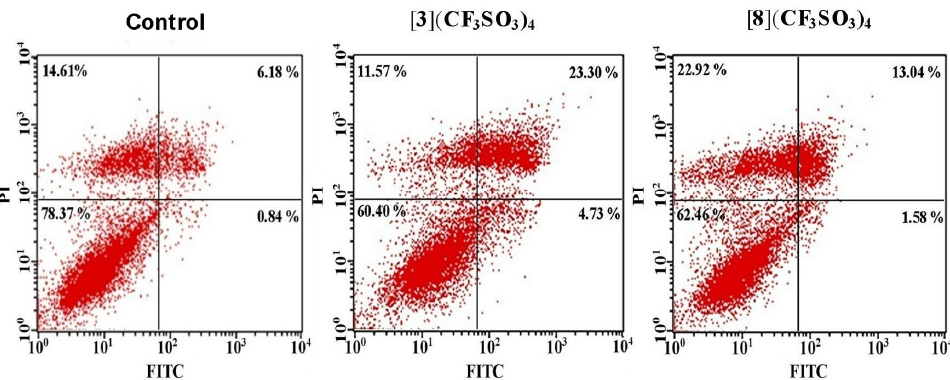
Figure 5. Untreated (control) and treated A-549 cells with metalla-rectangles 3 and 8 (500 nM). The cells were stained with annexin-V and propidium iodide and analyzed: viable (lower left), early apoptotic (lower right), late apoptotic (upper right), and necrotic cells (upper left).